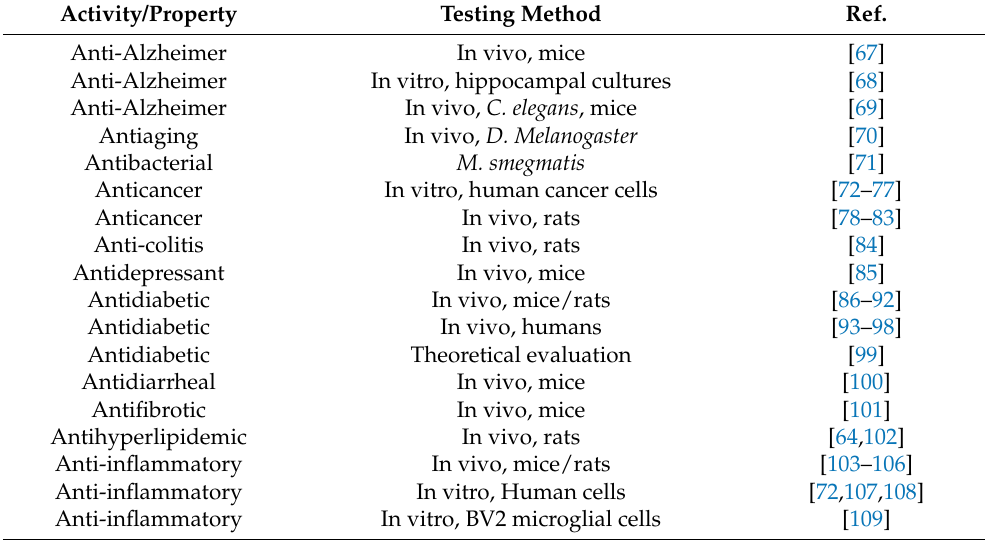
Table 5. Published properties of